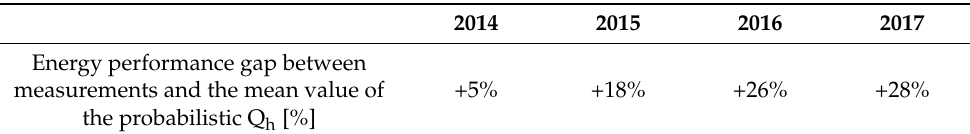
Table 5. Energy performance gap between the measurements and the median value of the probabilis- tic heating demand.